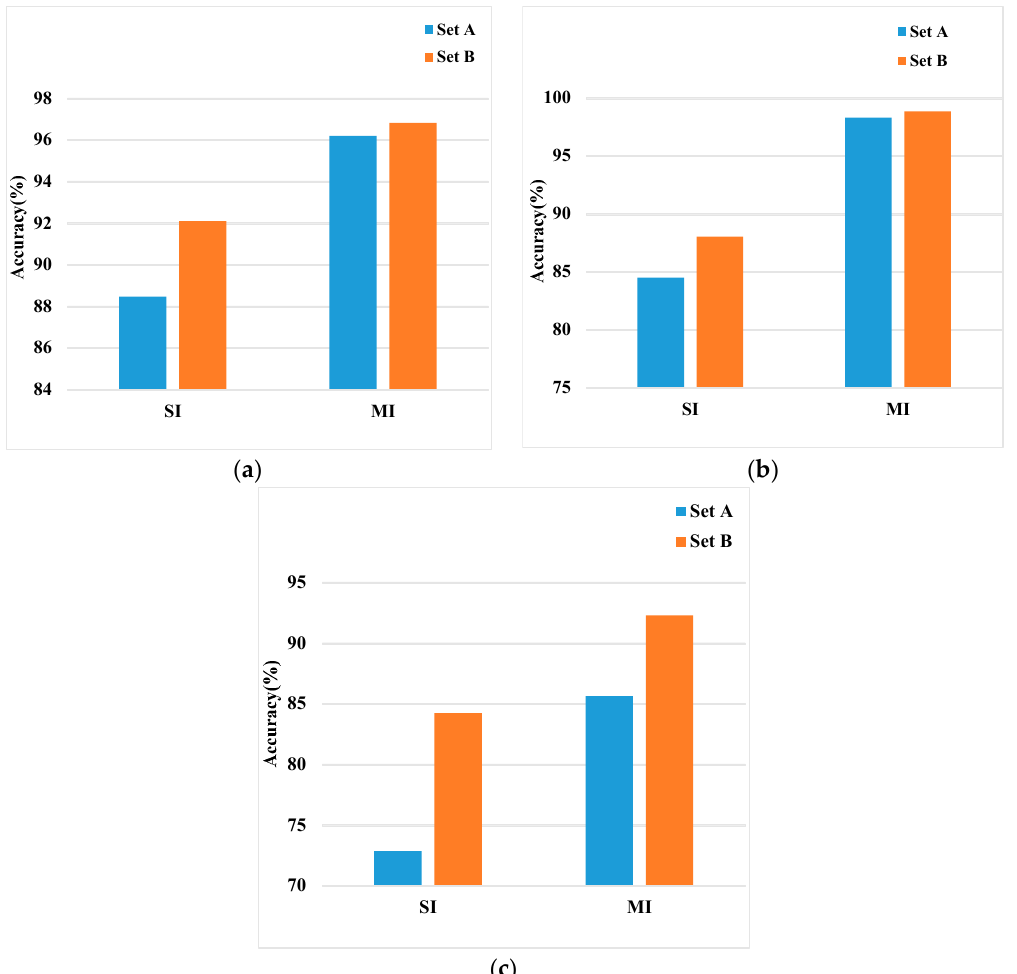
Figure 9. The accuracy comparison of the proposed method on Set A (Denoised) and Set B (Noisy). ( a ) Comparison on the MIT-BIH-AHA; ( b ) Comparison on the ECG-ID (Two-recording); ( c ) Comparison on the ECG-ID (All-recording). (SI—Single-heartbeat Identification; MI—Multiple-heartbeat Identification).